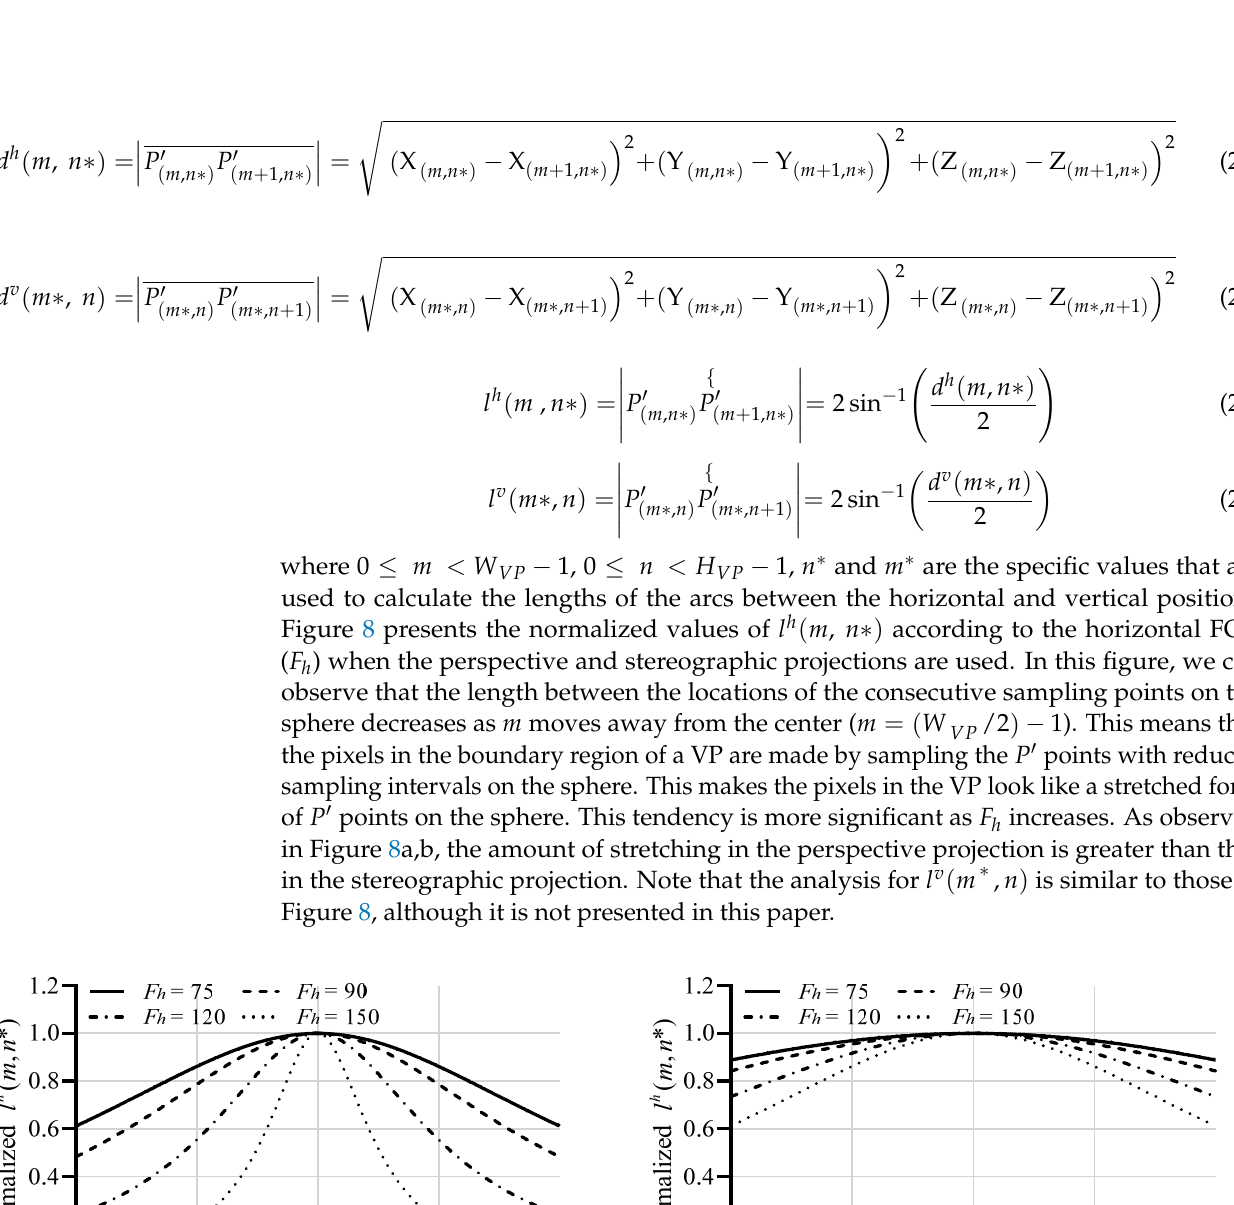
v Figure 9. Curved UV surface, which is the tangent surface for the unit sphere.